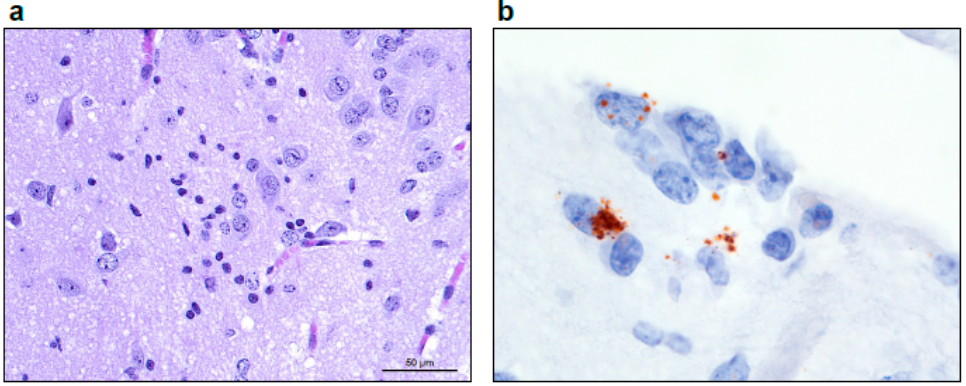
Figure 4. ( a ) Image taken at 400 × total magnification, 40 × objective of the (micro)glial nodule in the thalamus. ( b ) Using In situ hybridization targeting the EBOV genome, a glial nodule in the cortical white matter is stained and magnified at 1000 × total magnification (oil), 100 × objective.